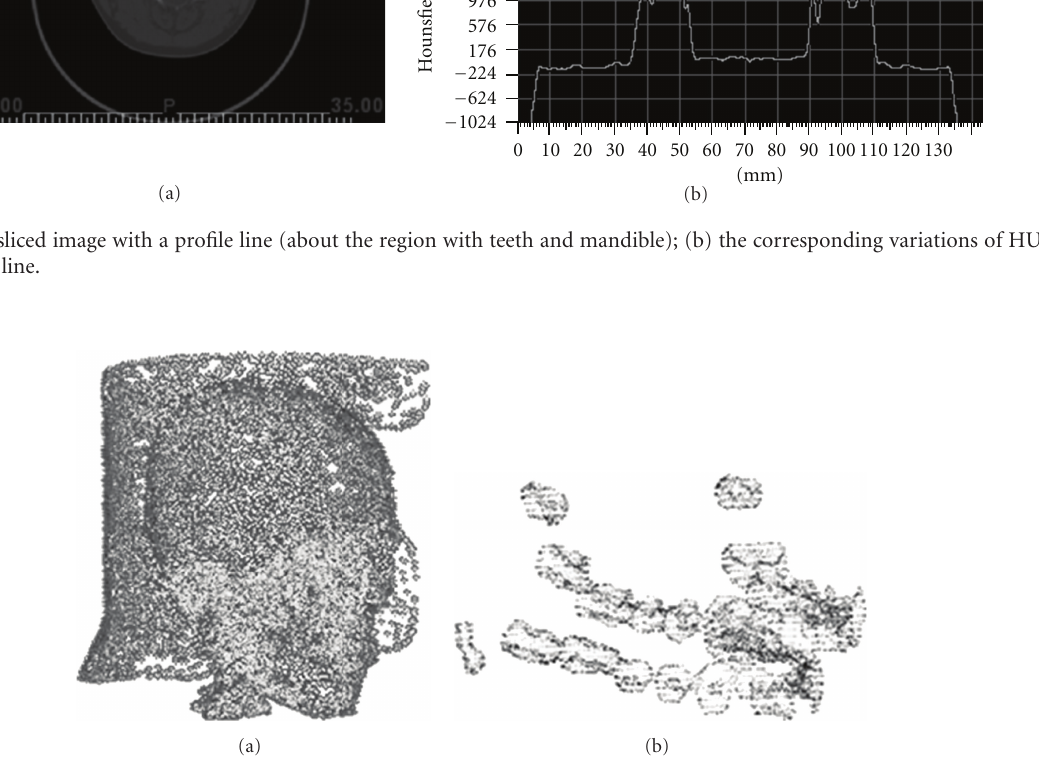
Figure 5: The preliminary obtained geometric point cloud data for (a) mandible, dentin, and pulp descriptions; (b) enamel